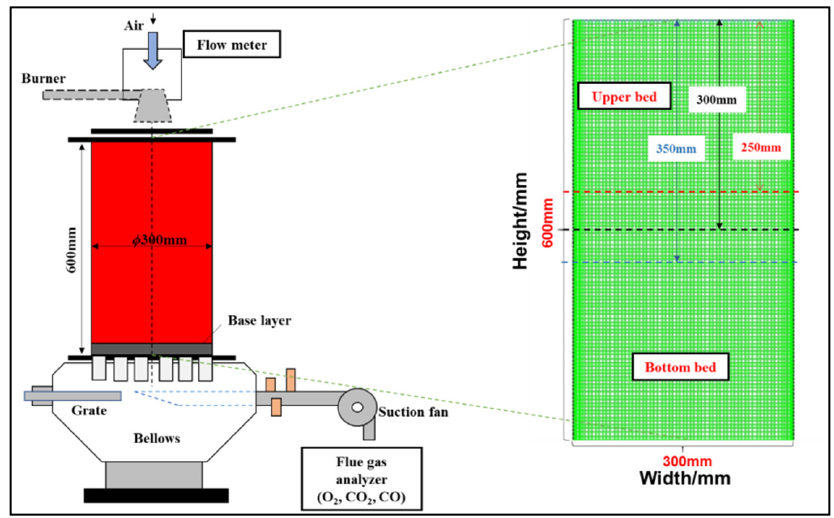
Figure 5. Schematic of the model calculation grid.